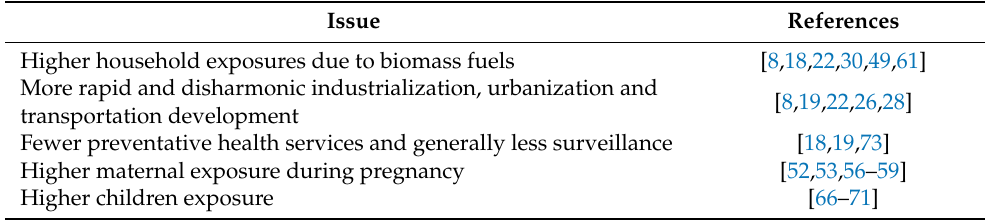
Table 1. The burden of air pollution in developing versus developed